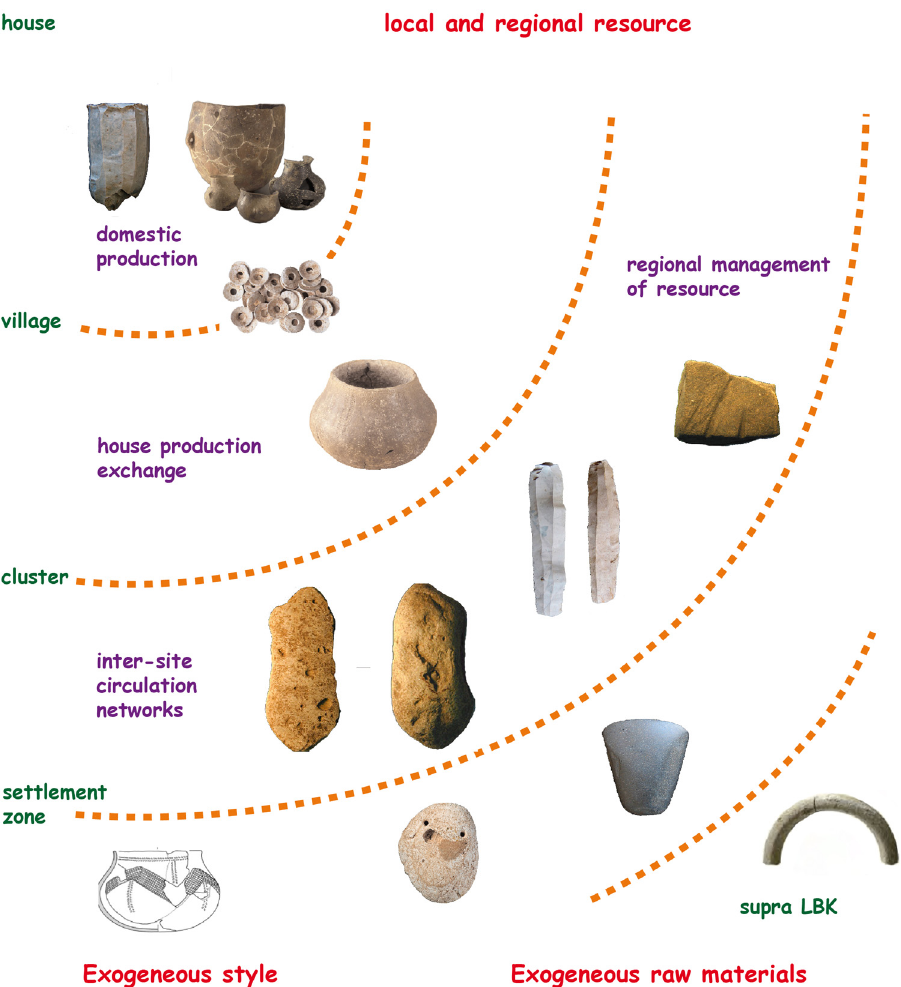
Figure 8: Di ff erent scales of raw material supply in the LBK settlements in the Aisne